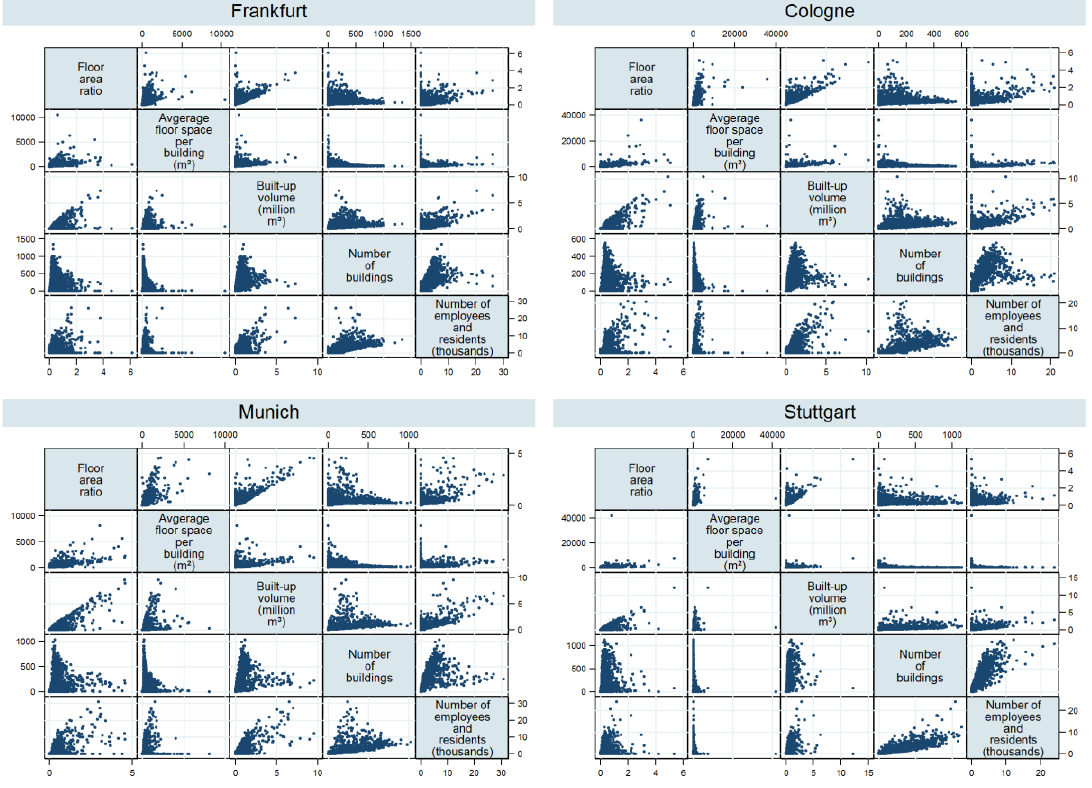
Figure 9. Scatterplot matrices showing the relationship between built and activity densities (both measured in levels). Employment data are taken from georeferenced Integrated Employment Biographies (georeferenced IEB) as of 30 June 2009, which are provided by the Research Data Centre (FDZ) of the Federal Employment Agency (BA) at the Institute for Employment Research (IAB) (for details and documentation, see [66])